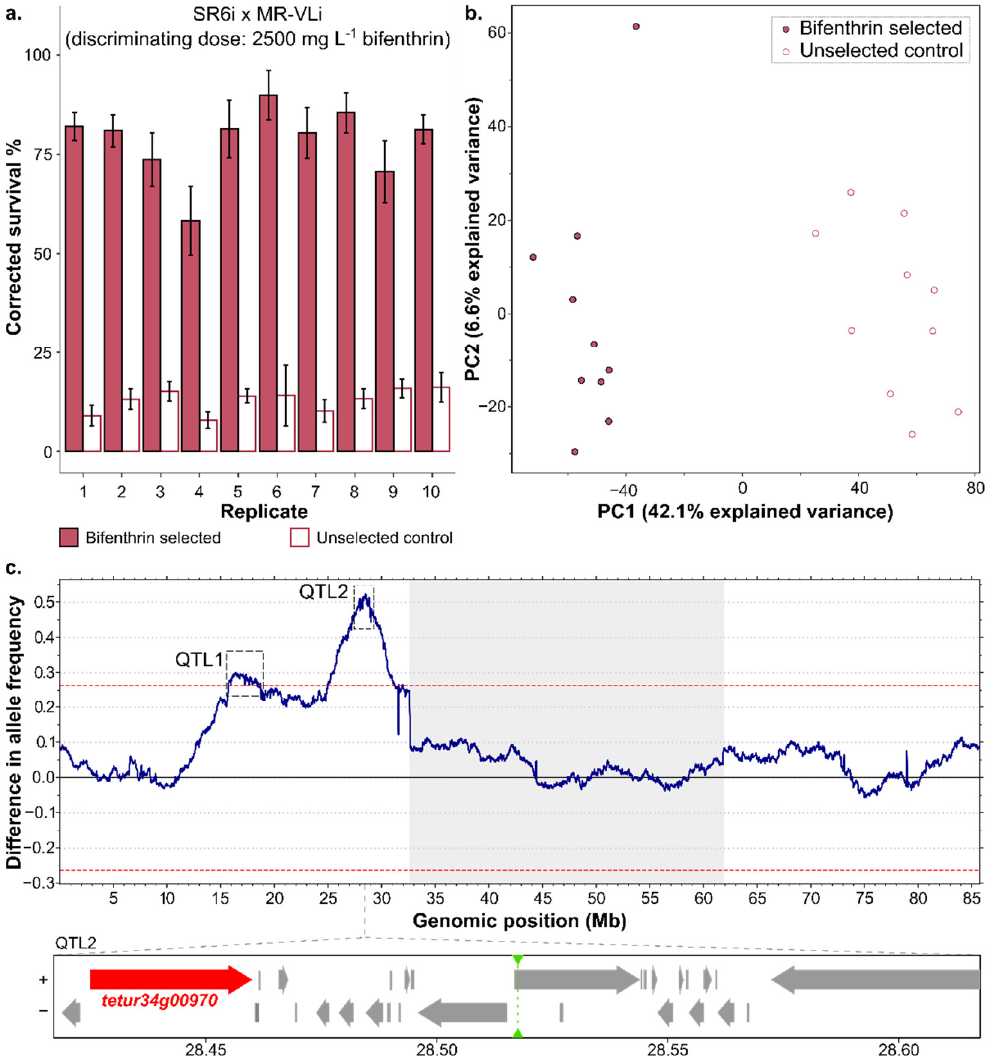
Figure 2. Bulked segregant analysis (BSA) to identify the genomic loci underlying bifenthrin resistance. ( a ) Adult survival of long-term selected and control (unselected) populations of SR6i x MR-VLi after acaricide application (2500 mg a.i. L −1 bifenthrin). The selected populations showed significantly higher survival rates compared to the control populations, showing that long-term bifenthrin selection results in bifenthrin resistance (F 1,69 = 867.76, p < 2.2 × 10 −16 ). Error bars represent the standard error of the mean. ( b ) Principal component analysis (PCA) of the unselected and bifenthrin-selected populations, based on genome-wide allele frequencies at polymorphic sites. PC1 clearly separates the selected populations from the unselected populations. ( c ) QTL mapping for bifenthrin resistance using a BSA. Averaged genome-wide differences in allele frequency using ten paired populations (bifenthrin-selected vs. unselected), with the dashed red lines delineating statistical significance for QTL detection (adjusted p -value ( p adj) of 5%). Two QTLs on chromosome 1 exceed the 5% p adj threshold: QTL1 (16.2–17.4 Mb) and QTL2 (~28.5 Mb). Genes within 100 kb of QTL2 are depicted below the graph, and tetur34g00970 , which encodes the VGSC, is highlighted in red. The location of the averaged BSA peak of QTL2 is indicated with a solid green triangle and a dashed line. The orientation of gene models is as indicated (“+” or “−” for forward and reverse strands, respectively).